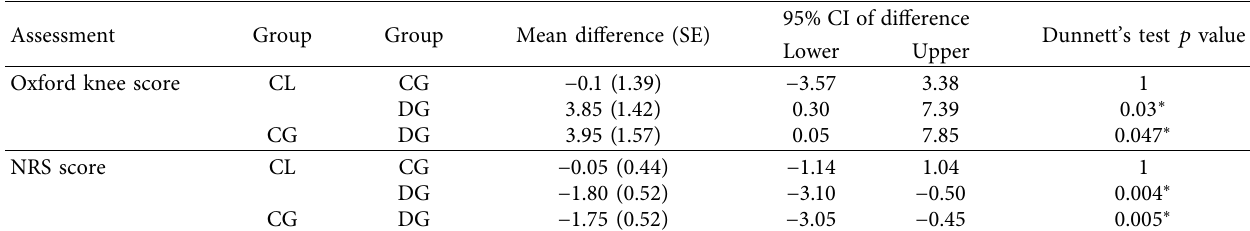
Table 3: Multiple comparisons of differences among procedures by using Dunnett’s test.